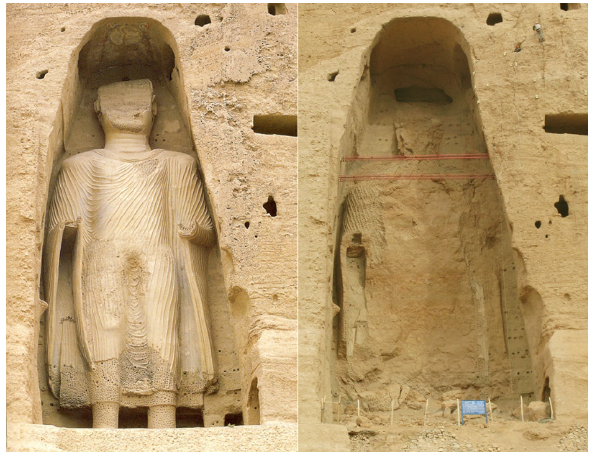
Figure 1. “Small” 38m Eastern Buddha of Bamiyan before